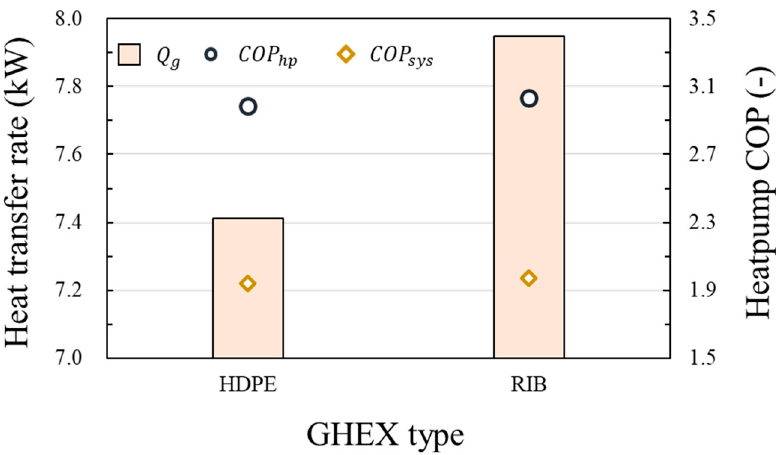
Figure 8. Heat pump and system coefficient of performance (COP) and heat transfer rate according to the ground heat exchanger (GHEX) shape.